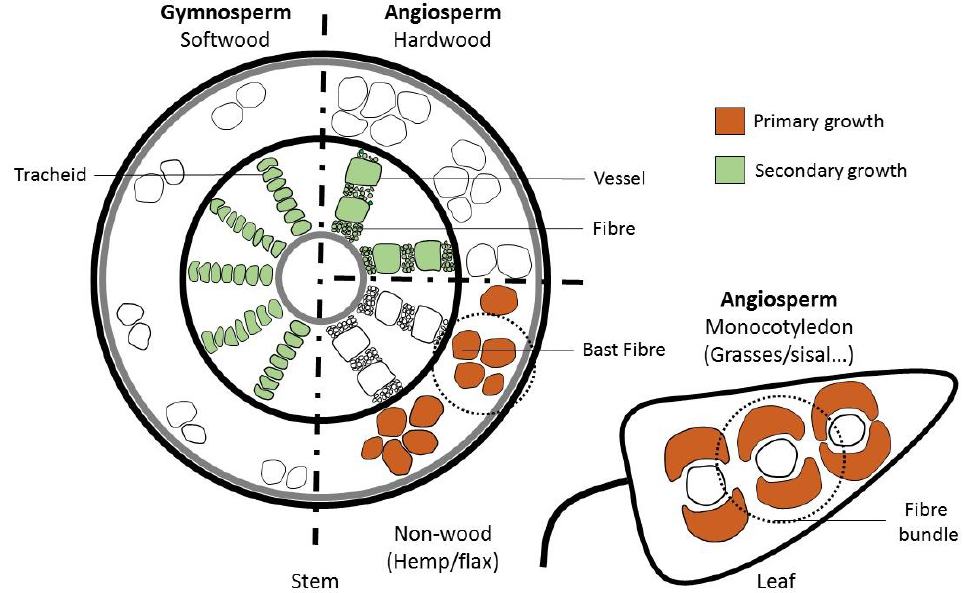
Figure 3. Origins of different types of fibres. The fibres extracted and used are represented in colour. Orange represents the primary growth and green the secondary growth. On the left-hand side, the gymnosperm (softwood) stem contains tracheids. The tracheids have the function of support and sap conduction. On the right-hand side, the angiosperm is divided into two categories. At the top is a hardwood with fibre and vessels. The fibres have mainly a support role, while the vessels are the principal sap conductive elements. The bottom part shows how stem and leaf are grouped in non-wood plants. Bast fibres are found in the stem, and monocotyledon fibres are found in the leaf (excluding bamboo). Both have a support role and are often found in bundles with other elements. The dotted circle represents a bundle of fibres that can be referred as ‘technical fibre’.